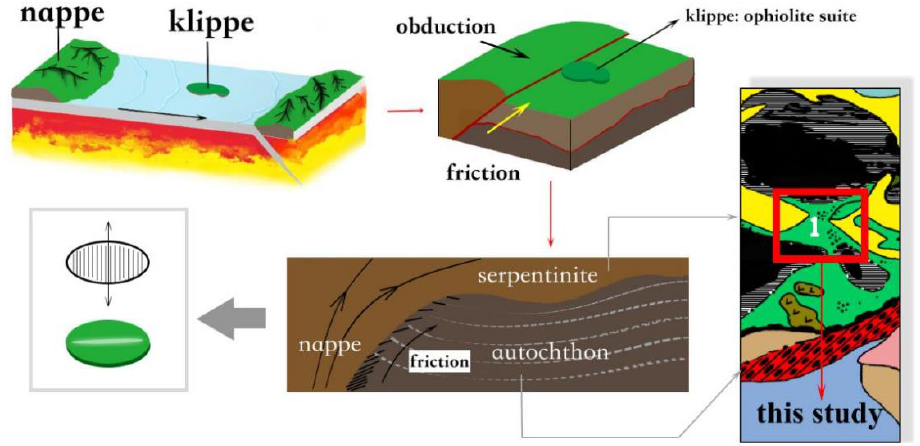
Figure 15. The geological origin of chatoyancy (caption is shown in Figure 1).